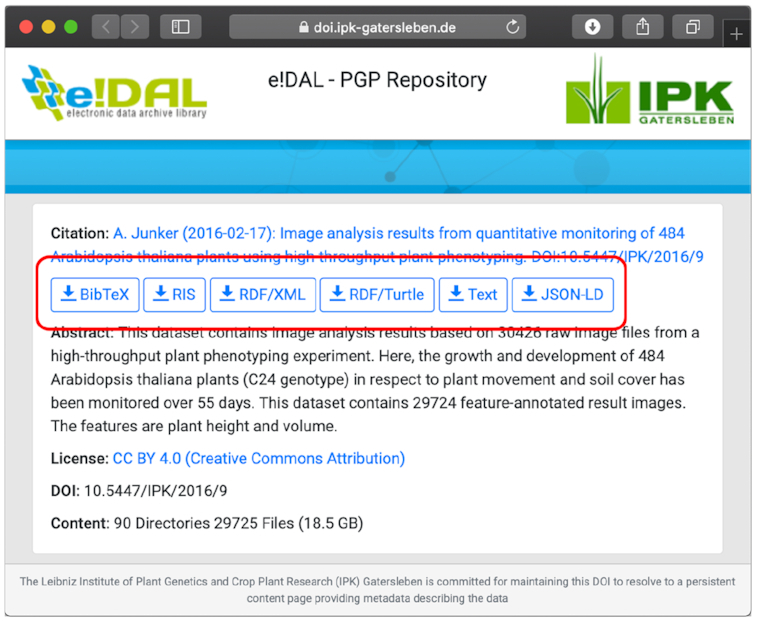
Screenshot of example datasets in the PGP repository. The red rectangle outlines the e!DAL embedded functions for content negotiation.